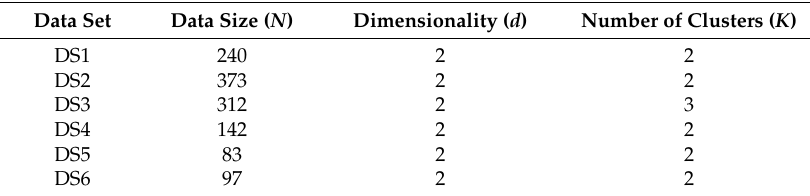
Table 1. Detailed description of